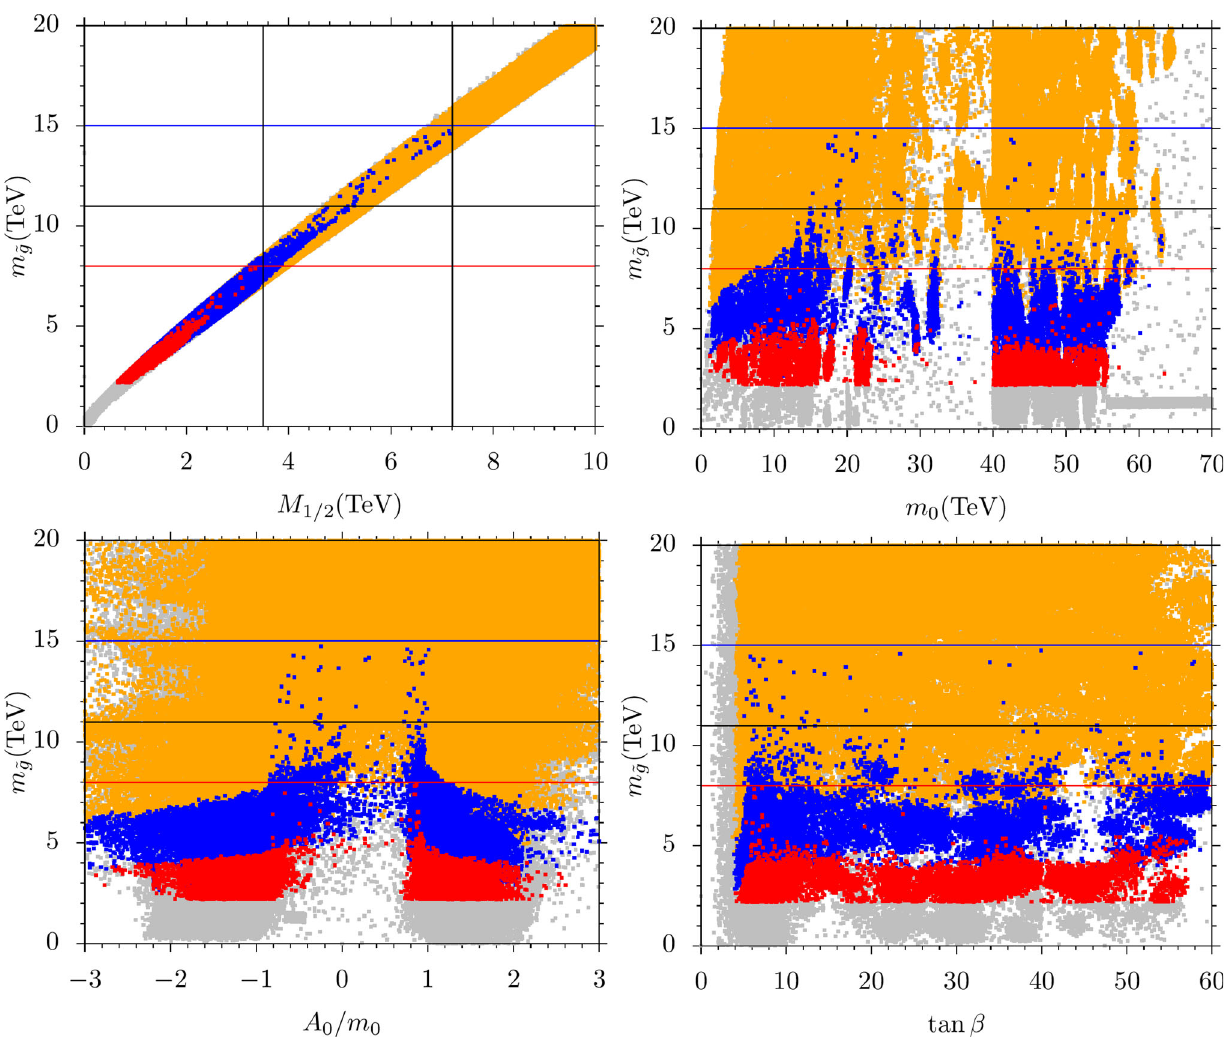
Fig. 2 The gluino mass versus supersymmetry breaking soft terms and tan β . The color coding is the same as in Fig. 1. Horizontal red, black and blue lines represent the gluino mass upper bounds of 8 TeV, 11 TeV, and 15 TeV corresponding to the red points, gluino discovery via heavy